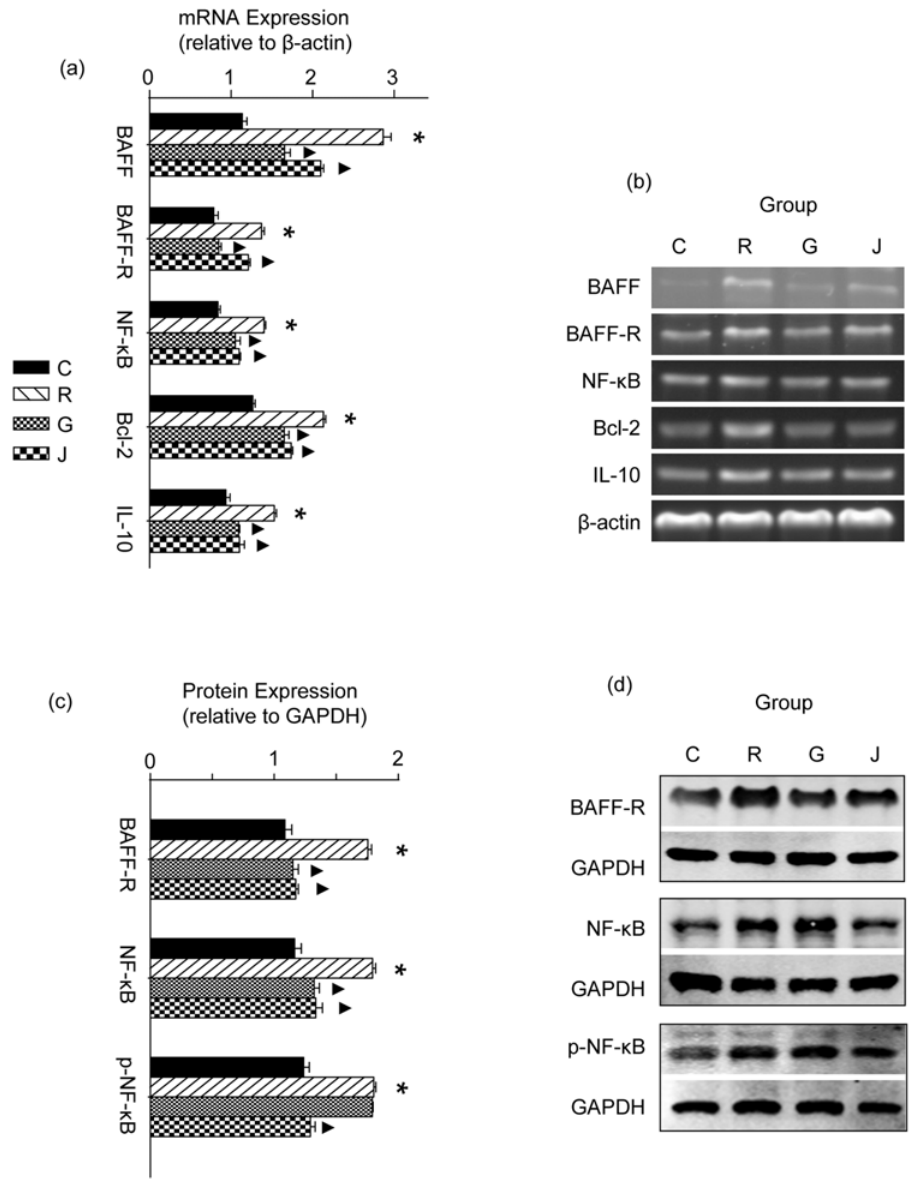
Fig 1. Effect of JP on the mRNA sxpression of BAFF, BAFF-R, NF- κ B, Bcl-2 and IL-10 in YAC-1 Cells. The mRNA expression was determined by RT-PCR, the mRNA level of β -actin was used as an internal control, and gene-specific mRNA expression was normalized against β -actin expression (a and b). The protein expression of BAFF-R, NF- κ B and phospho-NF- κ B in YAC-1 Cells was determined by Western blot (c and d). A GAPDH protein antibody was used as an internal control. Target protein expression was normalized against GAPDH protein expression. C represents the 10% blank-control serum group, R represents the 10% blank-control serum plus mBAFF group, G represents the 10% blank-control serum plus mBAFF and GC group and J represents the 10% moderate-dose JP-treated rat serum plus mBAFF group. Results are shown as means ± SD. * p < 0.05 compared with the C group, ▲ p < 0.05 compared with the R group.